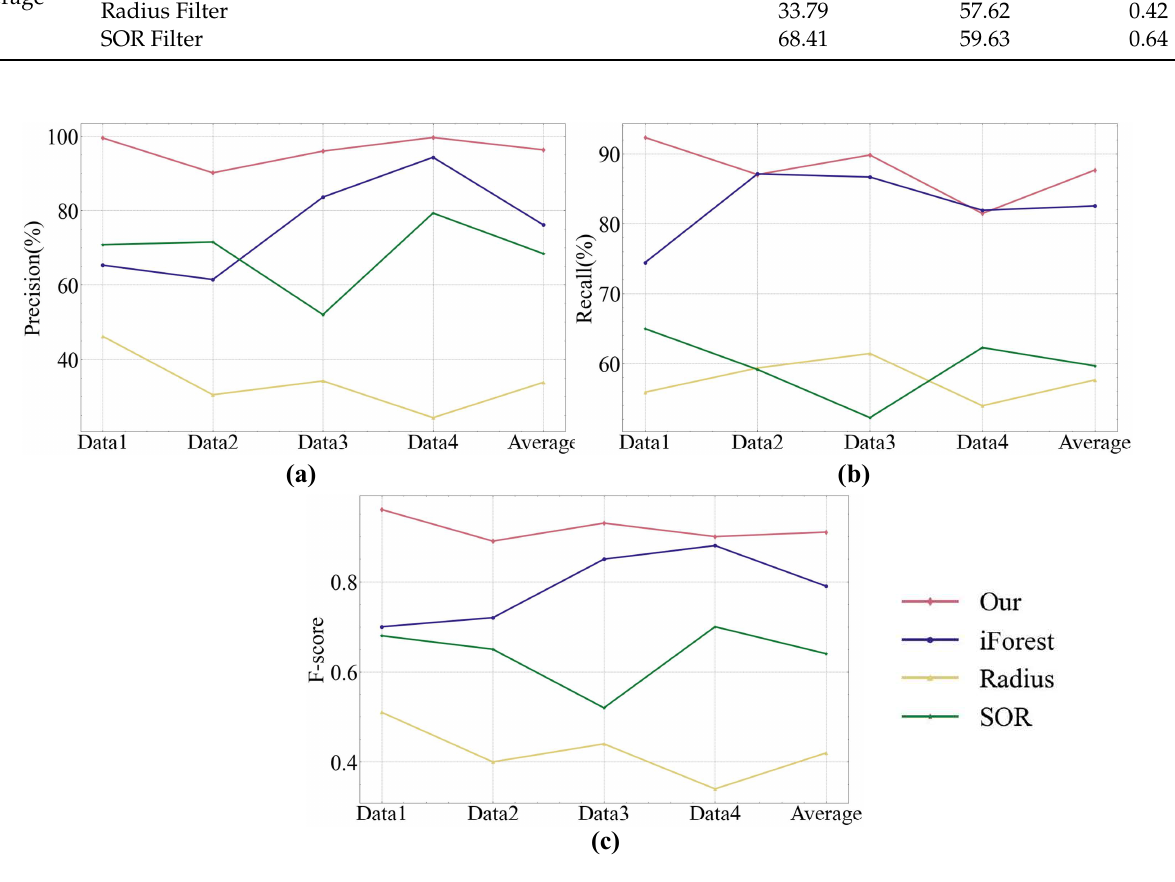
Figure 11. Comparison of the accuracy of the four denoising methods. ( a ) Precision comparison; ( b ) Recall comparison; ( c ) F-score comparison Table 3. Accuracy evaluation of trunk denoising experiment.